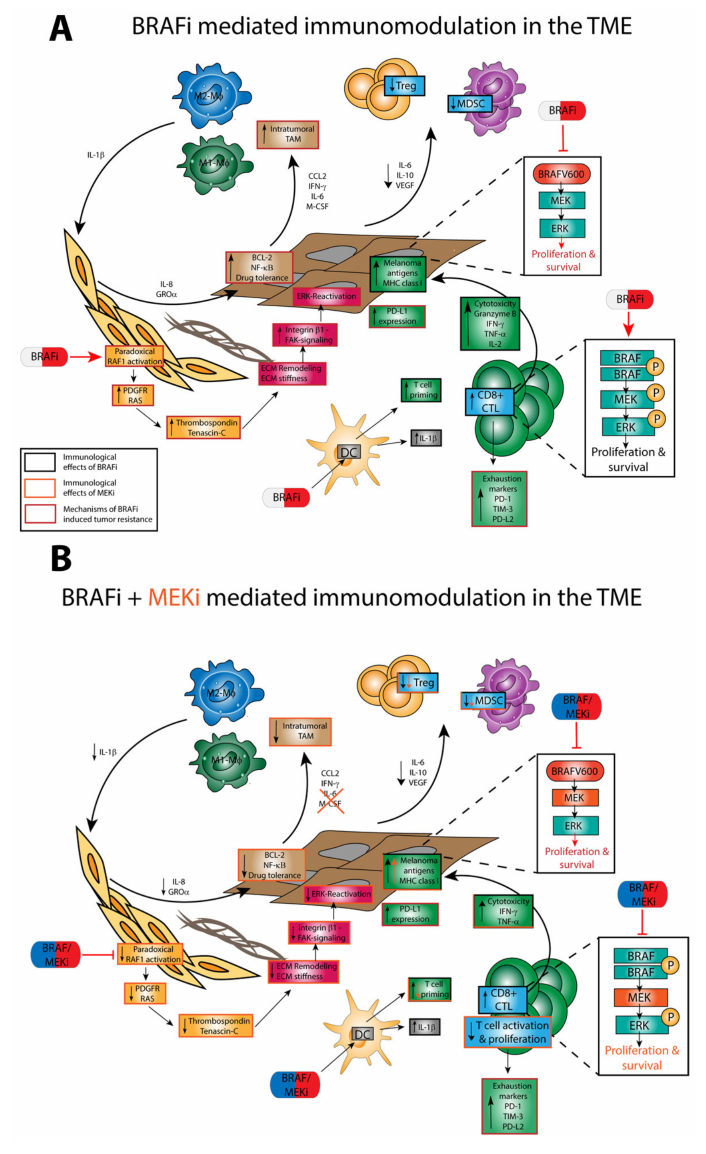
Figure 2. Immunomodulatory effects of BRAF (left) and MEK (right) inhibition on the tumor microenvironment. ( A ) BRAFi exert antiproliferative functions via blockade of ERK signaling in melanoma tumor cells. Moreover, BRAFi exert pivotal immunomodulatory functions within the TME. Here, it has been shown that BRAFi reduce the infiltration of Treg and MDSC within the TME via inhibition of IL-6, IL-10, and VEGF secretion by melanoma cells. Moreover, BRAFi enhance CD8 + T cell infiltration and activation via paradoxical ERK activation and augment cytotoxicity in T cells via the secretion of granzyme B, perforin, IFN- γ , and IL-2. Owing to increased immunogenic cell death, the expression of melanoma antigens and MHC-I molecules is significantly enhanced by BRAFi. However, BRAFi monotherapy also results in the development of mechanisms of tumor resistance. Among these, the functional crosstalk between TAM, cancer-associated fibroblasts (CAF), and melanoma cells contribute to rapid resistance to BRAFi [66]. Additionally, CAF contribute to tumor resistance via extracellular matrix (ECM) remodeling, resulting in the reactivation of ERK in melanoma cells [65]. Lastly, it has been found that BRAFi may increase both PD-L1 levels on melanoma cells, which may favor an exhausted T cell phenotype. ( B ) Coadministration of MEKi results in a decreased density of TAM, thus preventing the rapid development of treatment resistance. Further, MEKi prevent the polarization of monocytes into MDSC and the infiltration of regulatory T cells and MDSC into the TME. However, MEKi also reduce the proliferation and activation of T cells via blockade of ERK signaling, thus limiting the T cell stimulatory capacities of